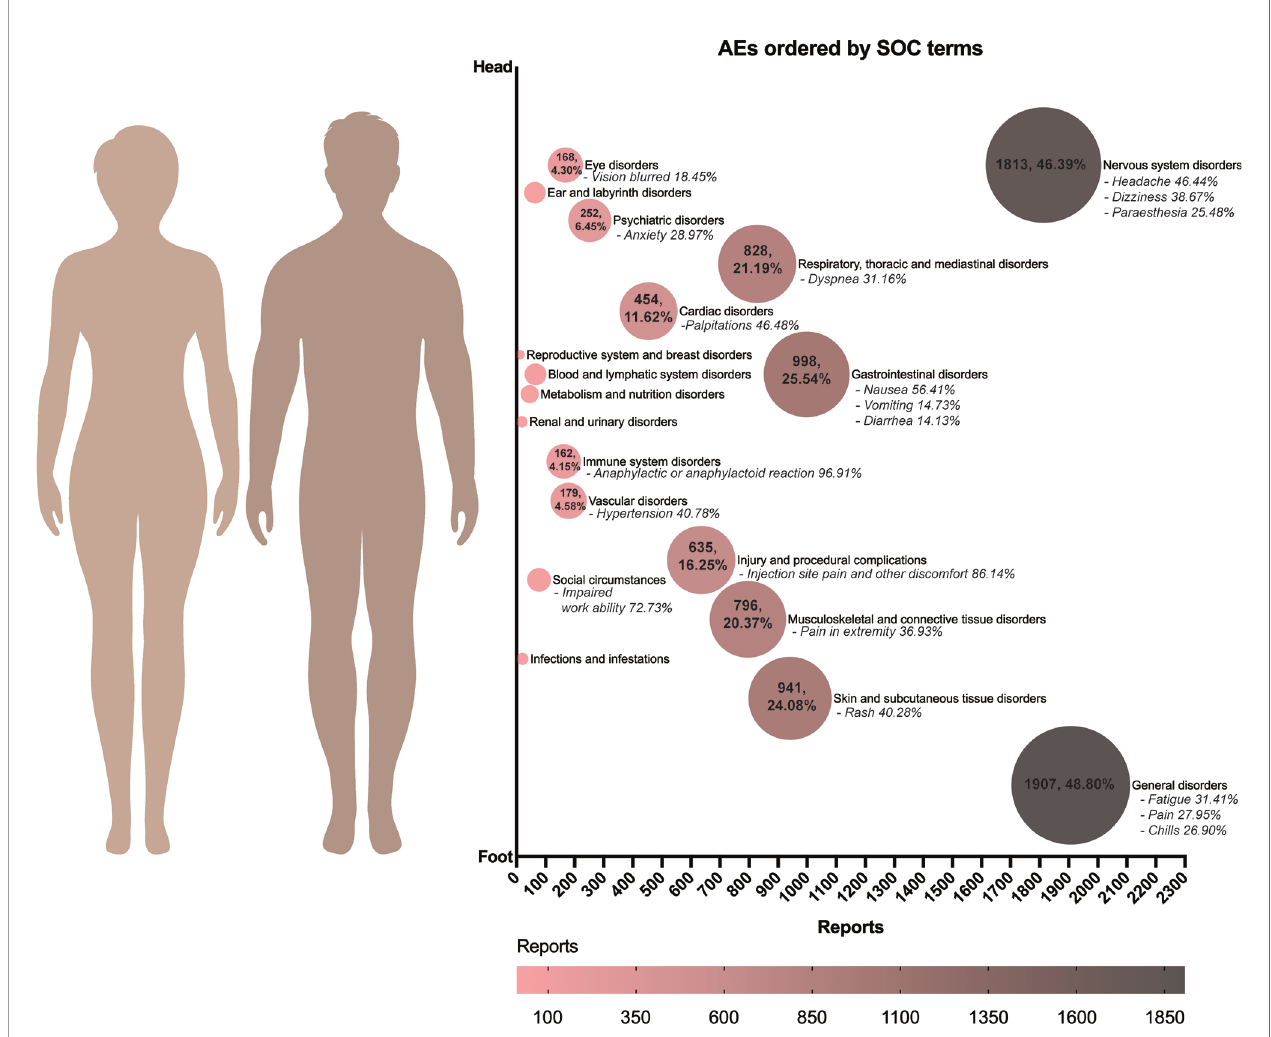
FIGURE 1 | The AEs after COVID-19 mRNA vaccines classi fi ed with SOC terms in VAERS database in December 2020. The bubble plot showed the case numbers and percentages of different AEs among the total of people who reported AEs. AEs were generally sorted by organs from head to feet of a human body. More common AEs were represented with larger bubble sizes and darker colors. COVID-19, coronavirus disease 19; AE, adverse event; VAERS, Vaccine Adverse Event Reporting